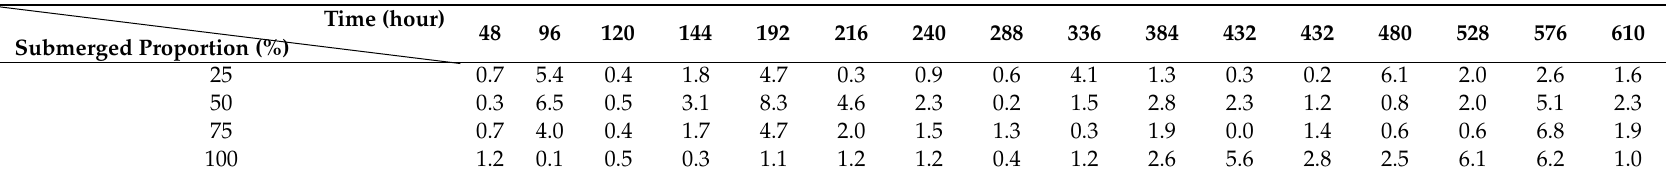
Table A5. Standard deviations of dissolved oxygen (mg / L) in the catholyte of microbial fuel cell (MFC) reactors with the cathode electrodes submerged at the proportions of 25%, 50%, 75%, and